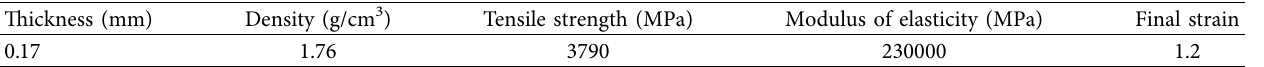
Table 3: CFRP carbon fiber [17].